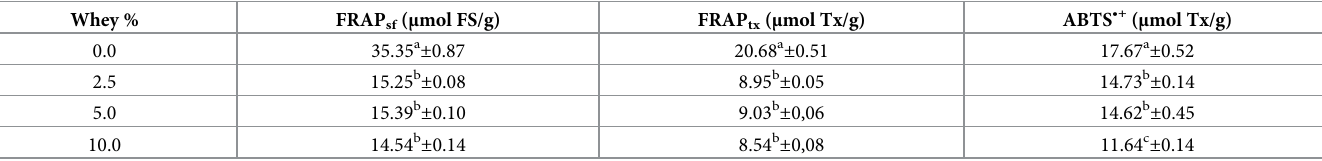
FRAP ( ferric reducing antioxidant power; ABTS •+ (2,2’-azino-bis(3-ethylbenzothiazolin)-6-sulfonic acid). Different letters indicate significant differences for different treatments (p <